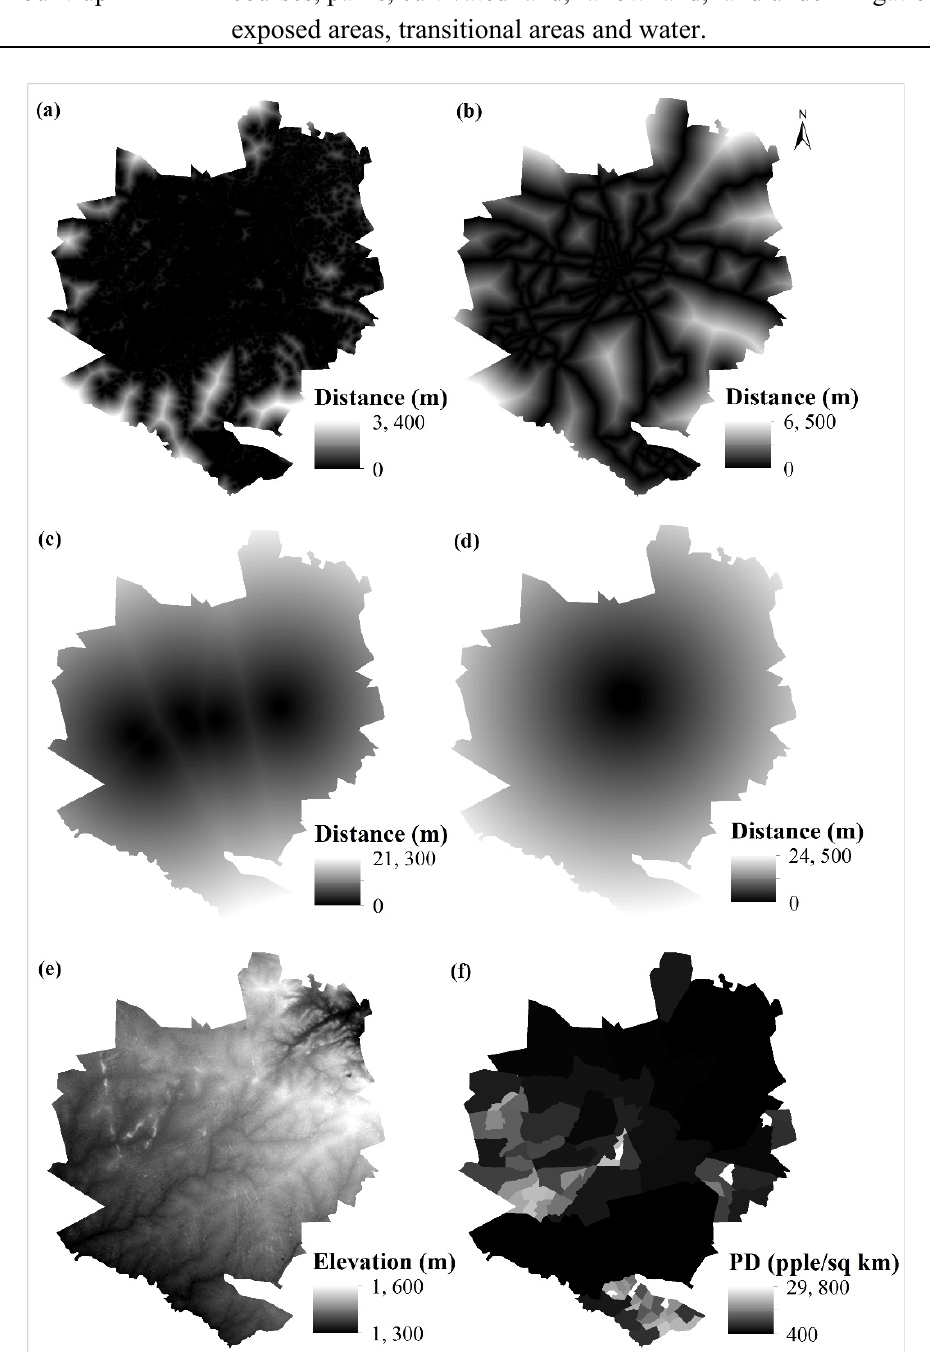
Figure 3. Selected driving factors used to compute transition potential maps: ( a ) distance to built-up areas (2002); ( b ) distance to major roads (2002); ( c ) distance to major industrial centers; ( d ) distance to city center; ( e ) elevation; and ( f ) population density